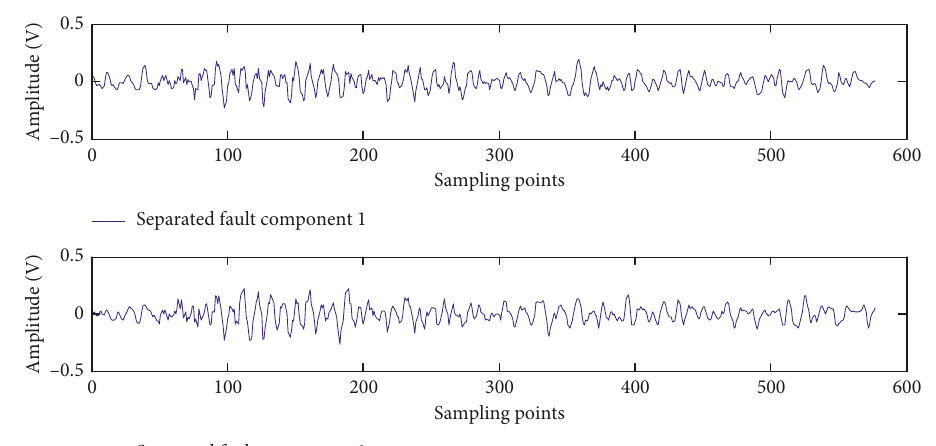
I 110 (cid:31) ( I 1 + I 3 + I 5 + I 7 + I 9 + I 11 + I 13 + I 15 + I 17 + I 19 + I 21 )